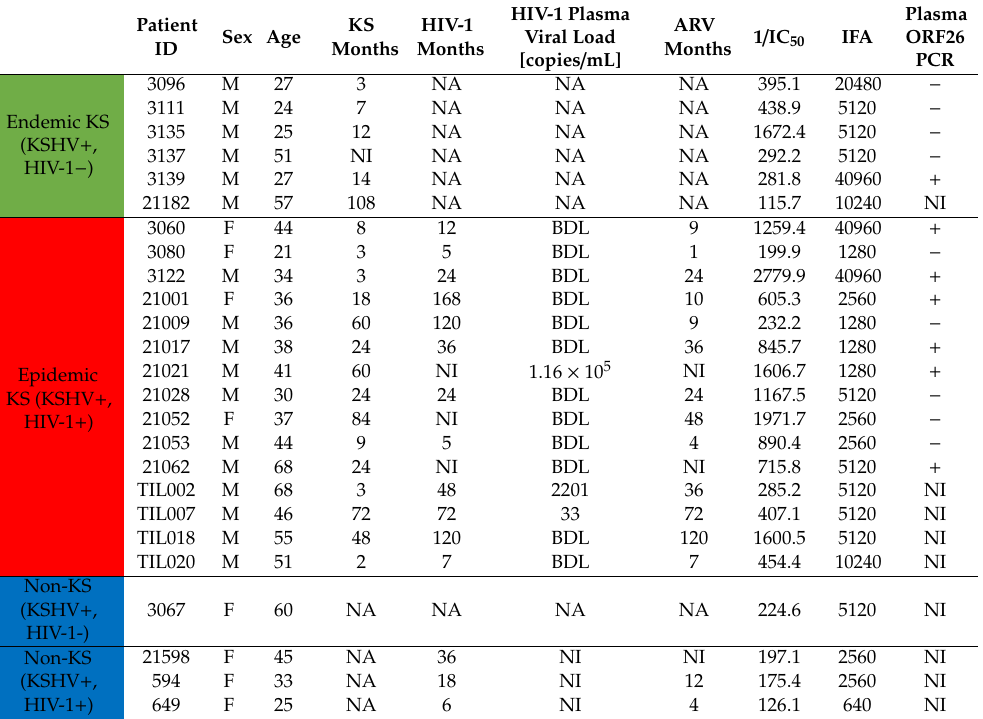
Table 1. Characteristics of the study